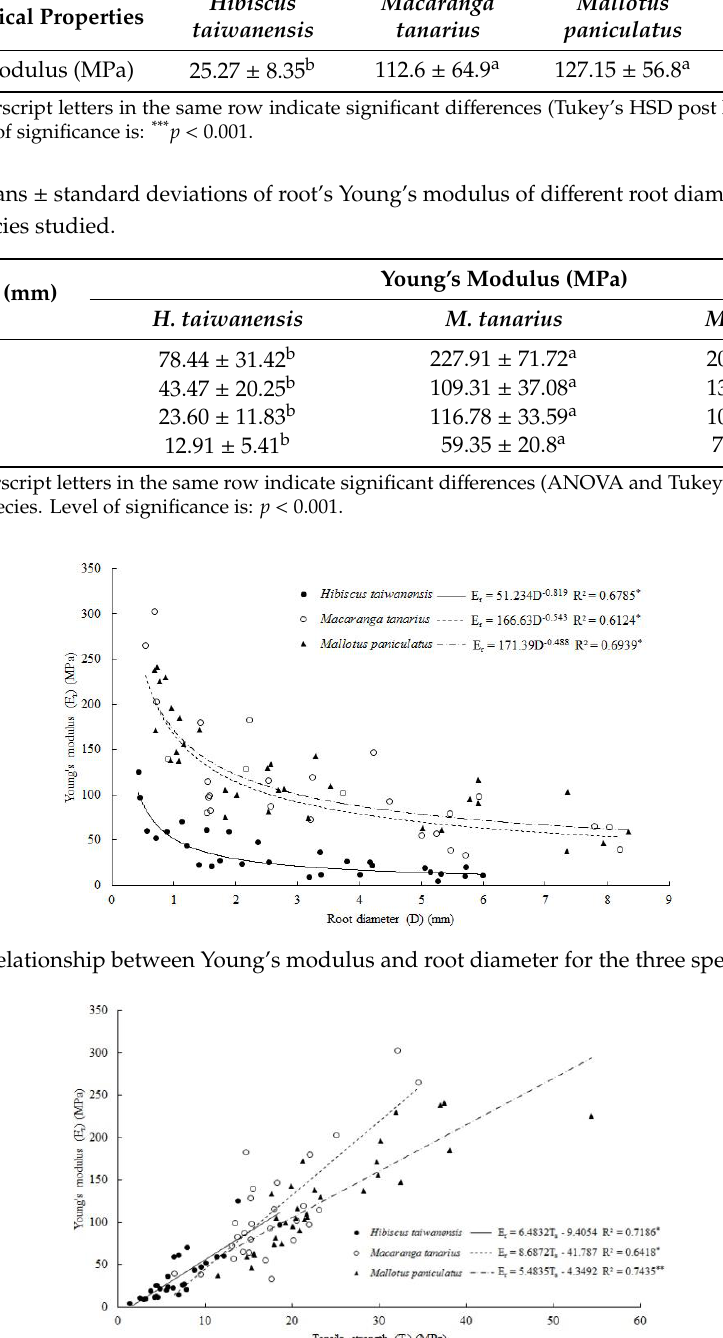
Table 10. Means ± standard deviations of root Young’s modulus for the three species studied and F-values for one-way ANOVA.